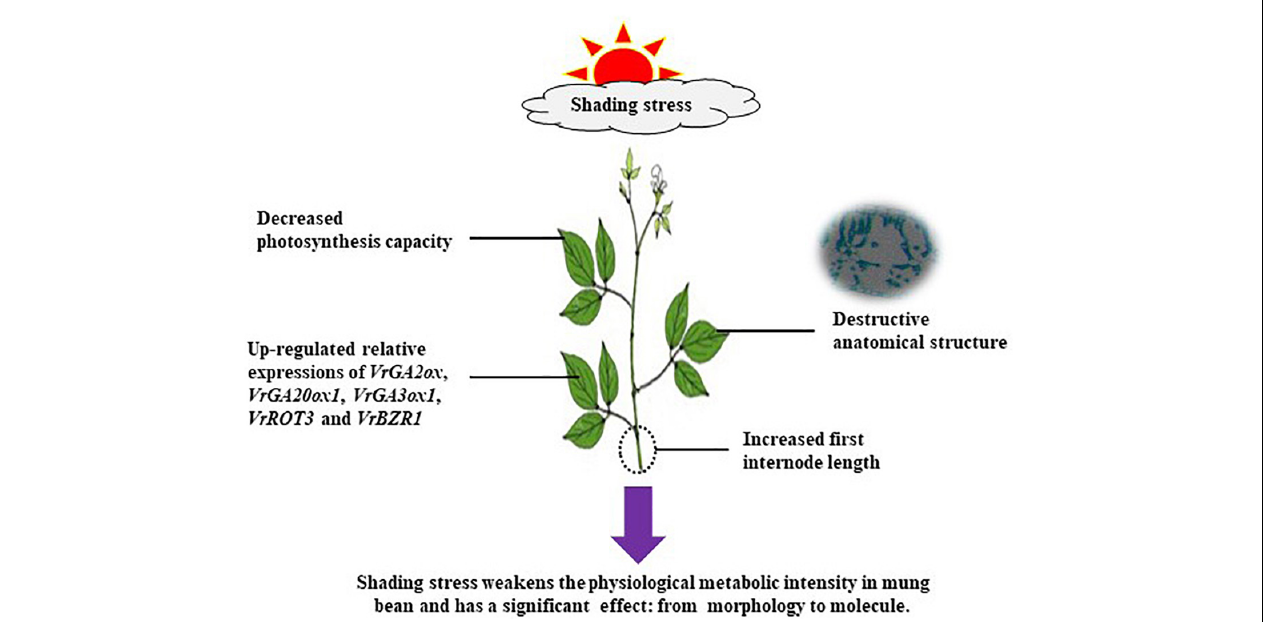
FIGURE 9 | Schematic representation of changes in morphological characteristics, leaf physiology, and photosynthetic characteristics of mung bean plants as affected by shading stress.